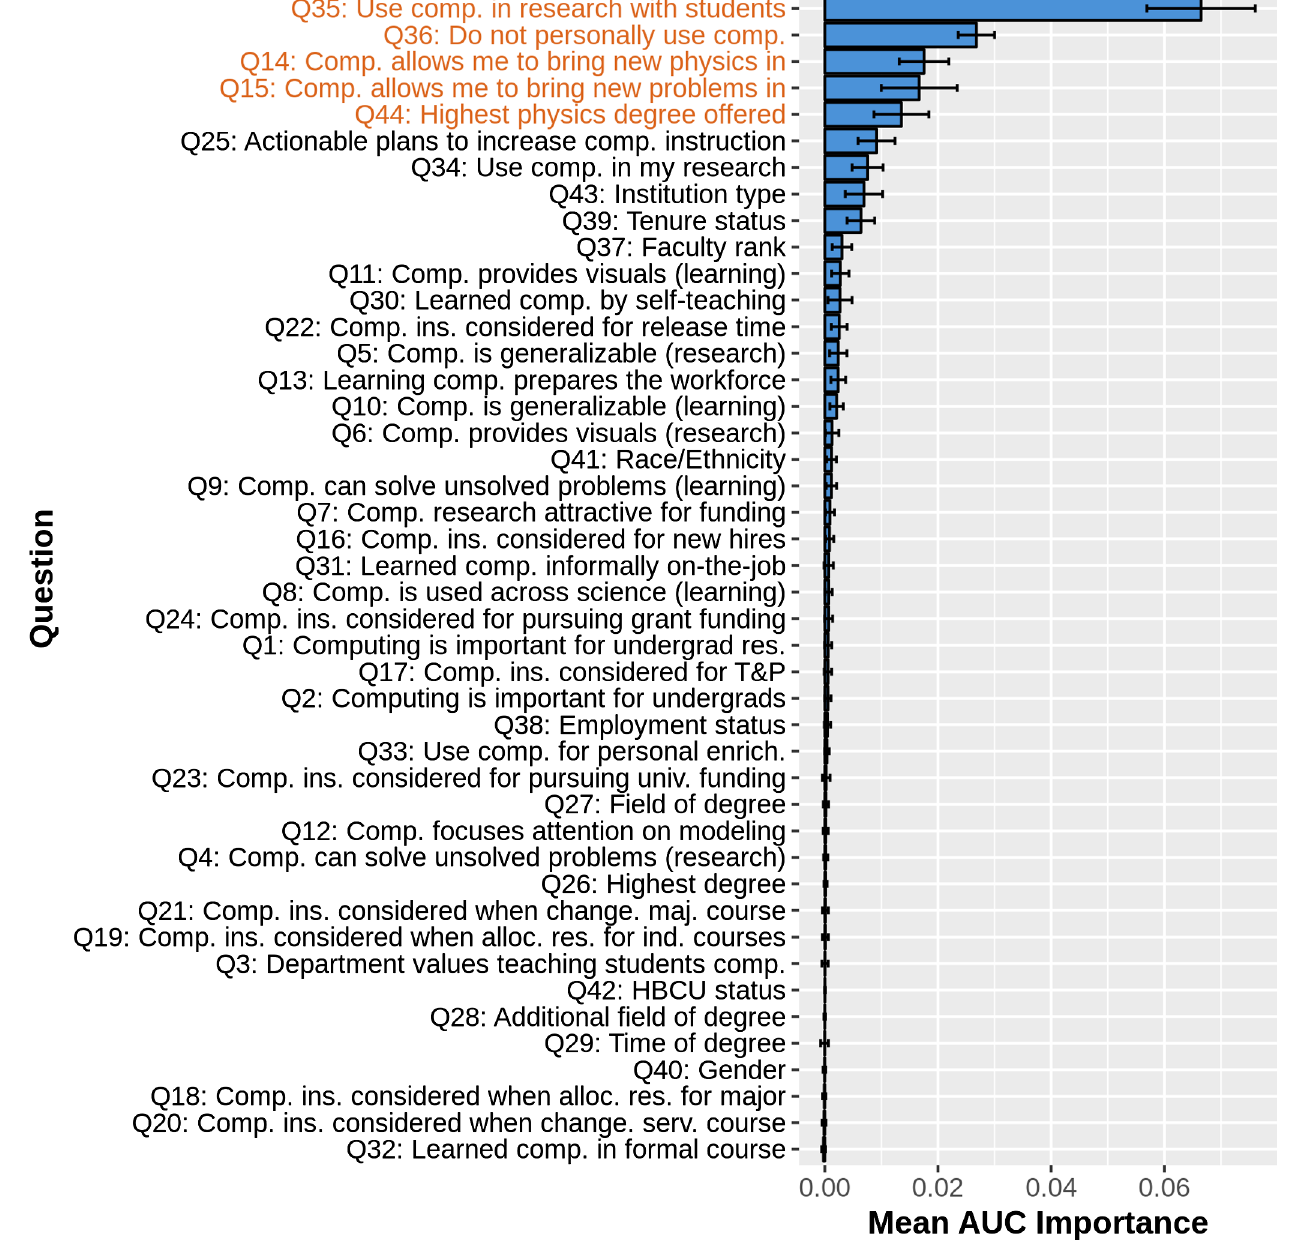
FIG. 2. Variable importances for each of the 44 factors used to predict whether a faculty member has experience teaching computation. The importance is based on the average change in the AUC if the factor is permuted. Thus, factors that change the AUC the most have the largest importances. The first five factors in color are the ones selected from the recursive backward elimination approach. The error bars represent a standard error of the mean AUC importance. Full questions can be found in Table 2 of the